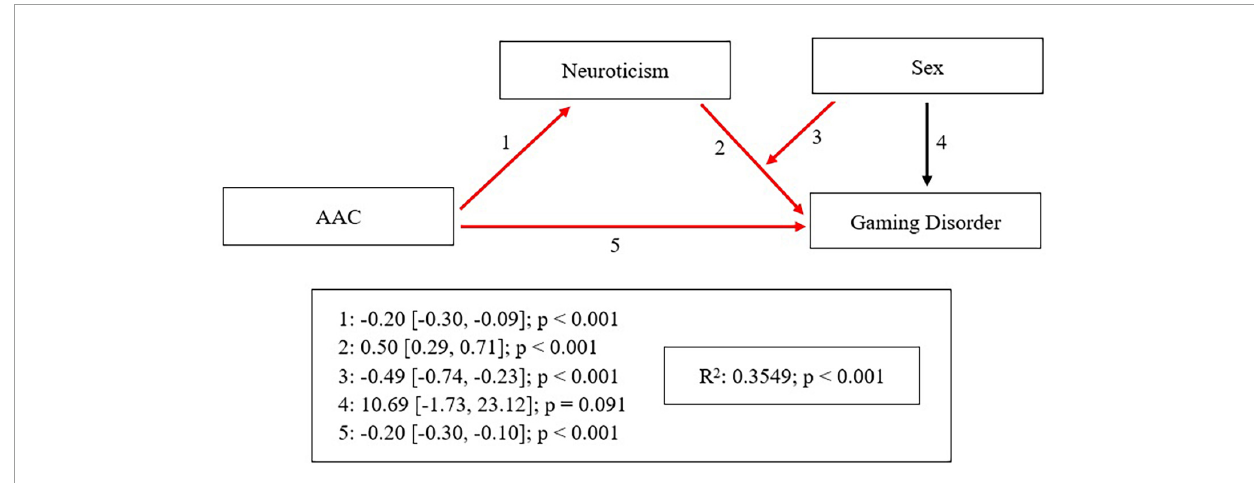
FIGURE1 Explanatory model between parenting, personality, and Gaming Disorder. Significant relationships are shown in red. AAC, Adolescent